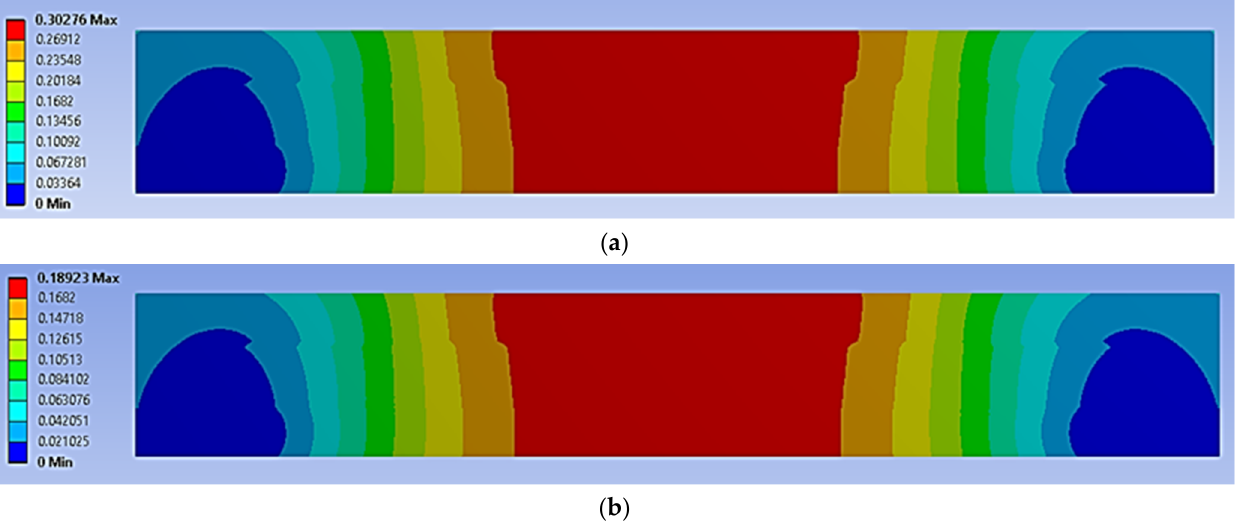
Figure 10. The stress distribution on the bonding area of a simulated panel under cyclic loading conditions (units in MPa): ( a ) 70%, ( b ) 50%.